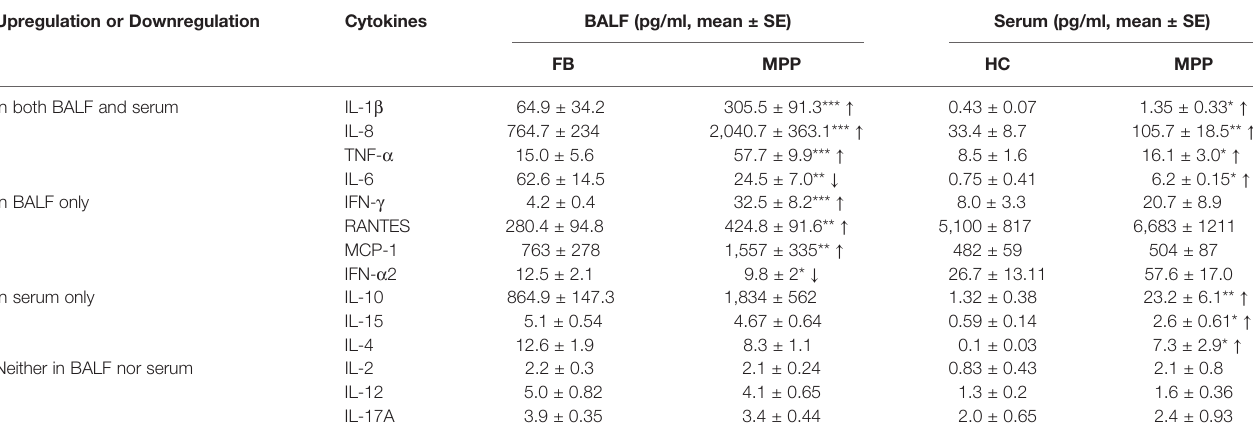
TABLE 2 | Cytokine/chemokine expression in BALF and serum. Upregulation or Downregulation Cytokines